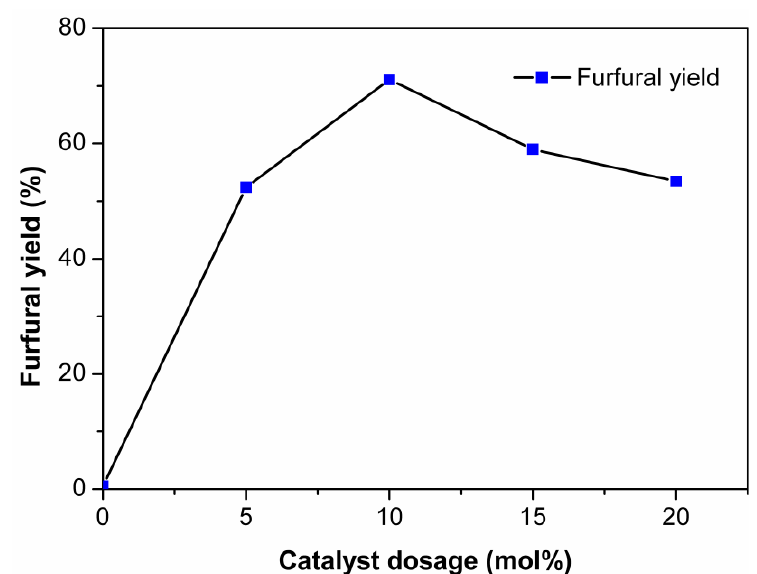
Figure 2. Effect of catalyst dosage on the dehydration of xylose into furfural. Reaction conditions: 200 mg of xylose was dissolved in 1000 mg of EMIMBr; 130 °C; 1 h.